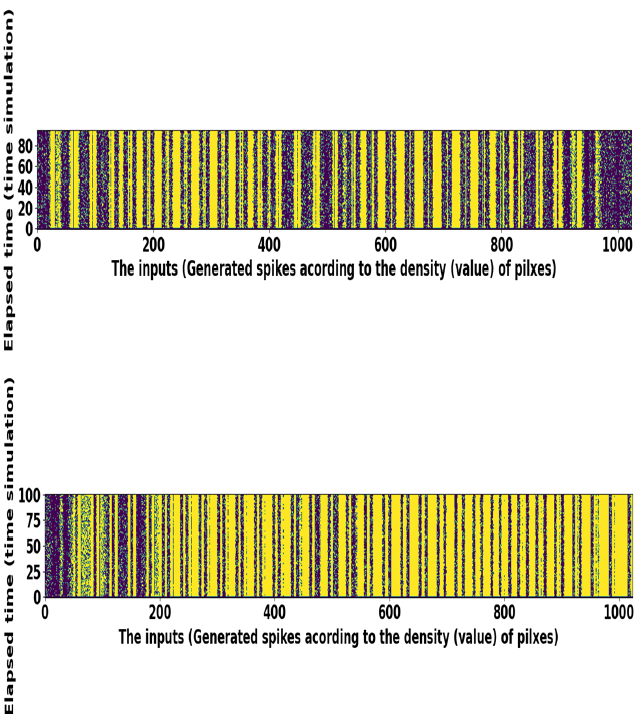
Figure 6. Raster plots of random spike trains taken from the license plate